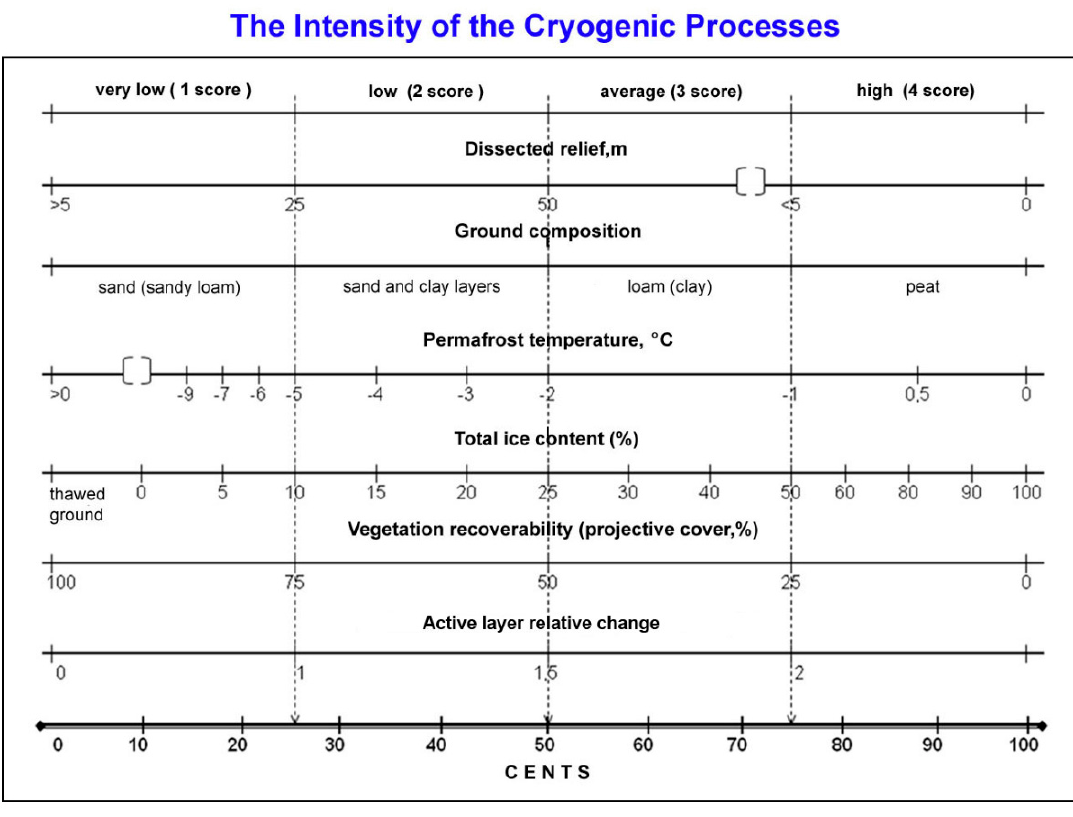
Figure 1. The ratio of the estimated factor scales affecting the intensity of cryogenic processes in Western Siberia.